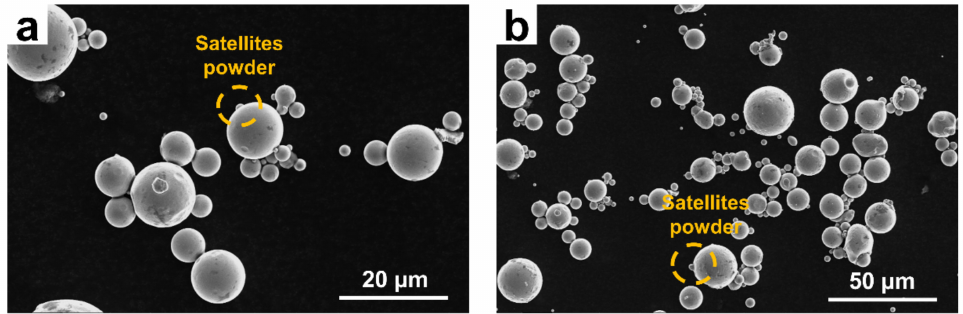
Figure 1. SEM of Al 0.5 CoCrFeNi HEA powder. ( a ) 20 µ m, ( b ) 50 µ